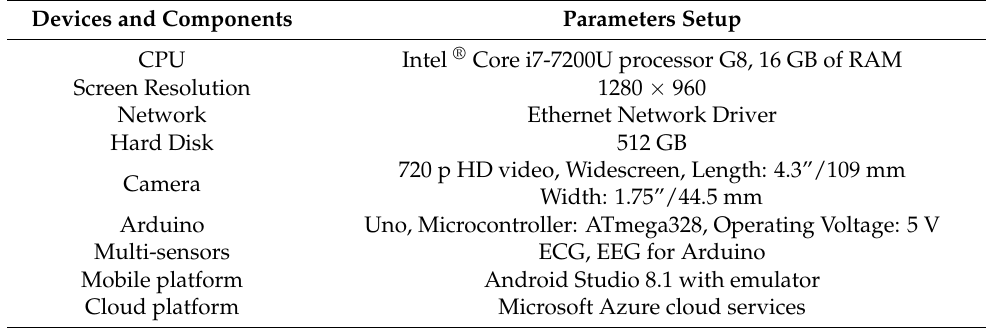
Table 6. Major components and devices used to compare state-of-the-art hybrid systems by using IMSIU university driver’s simulator